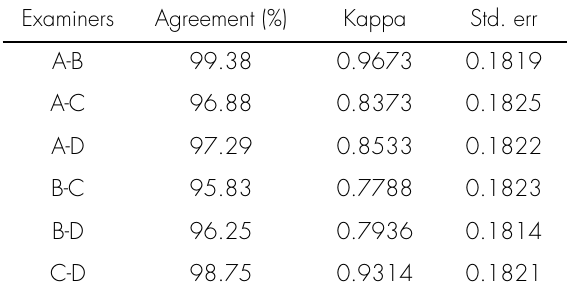
Table VIII. Inter-examiner agreement and Kappa of the IOTN-DHC for the photographs of study models. Examiners